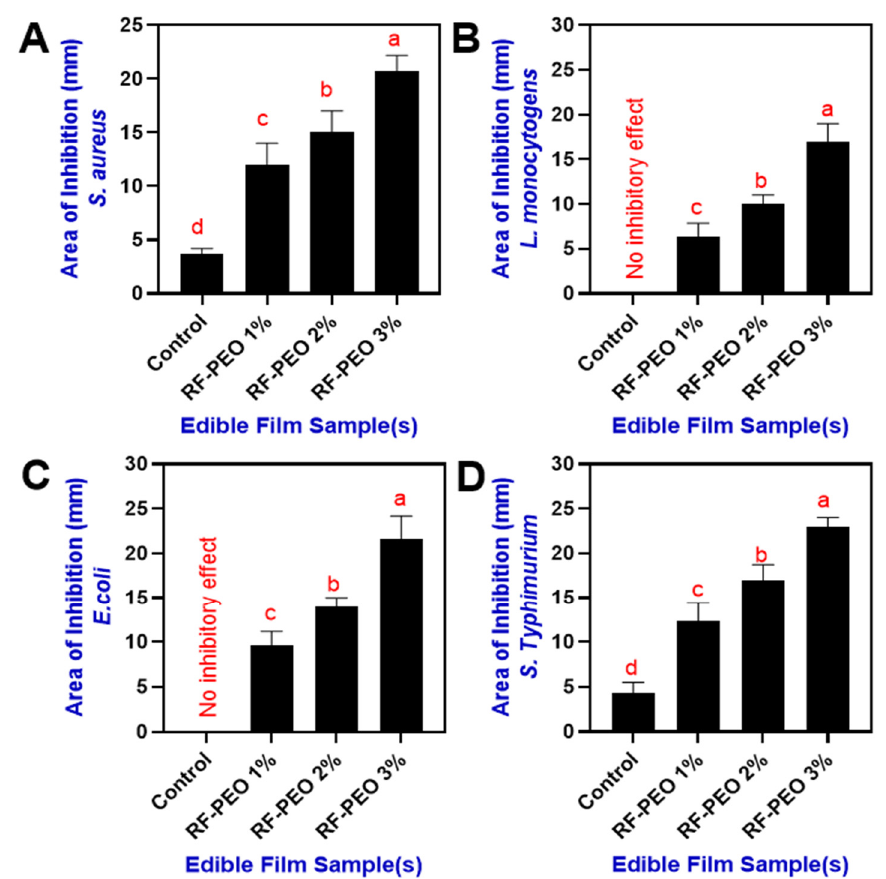
Figure 9. Antimicrobial activity of edible films composed of RF–PEO at varying concentrations against selected pathogens including ( A ) S. aureus , ( B ) L. monocytogens , ( C ) E. coli , and ( D ) S. typhi-murium .